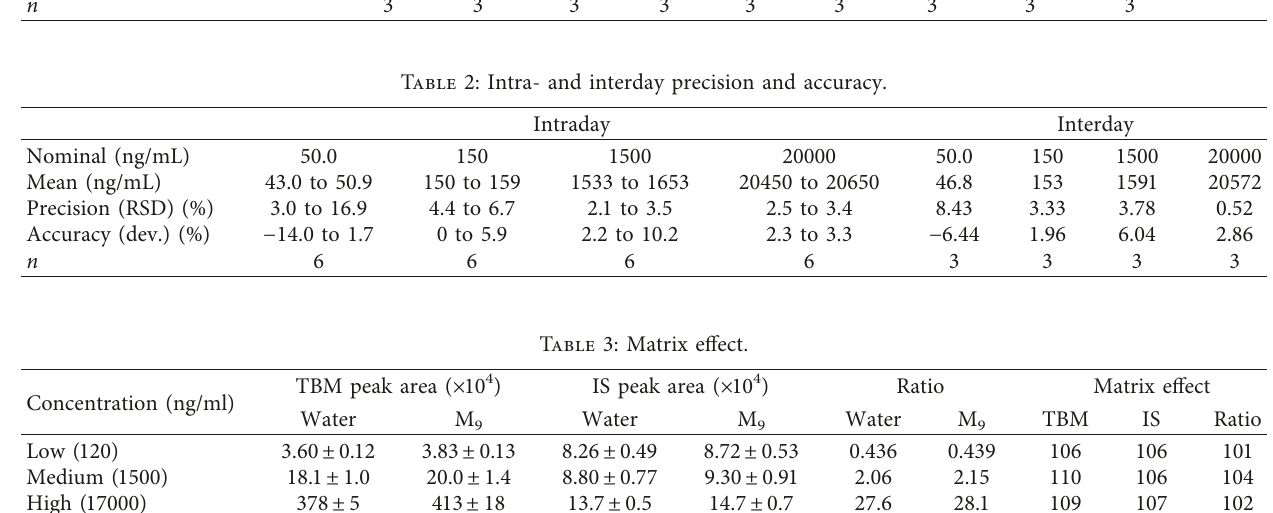
Data represent the mean peak area ( ± SD) from triplicate